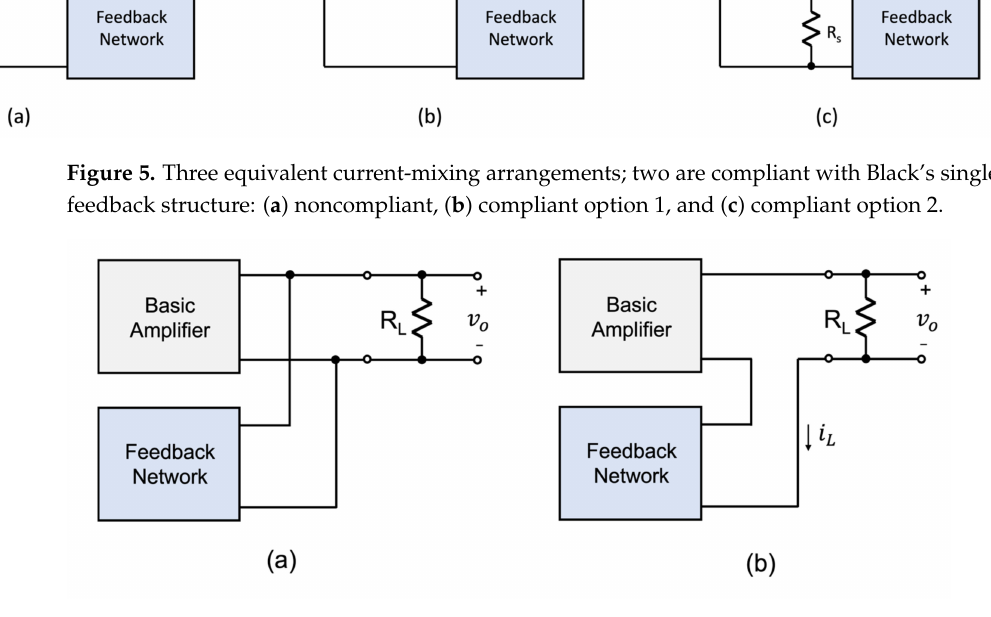
Figure 6. Highlighting the physical difference between an output signal from a circuit with a feedback loop and the signal being sensed by the feedback network. ( a ) The output voltage is the same signal that is being sensed by the feedback network, and ( b ) the output voltage is different from the current signal that is being sensed by the feedback